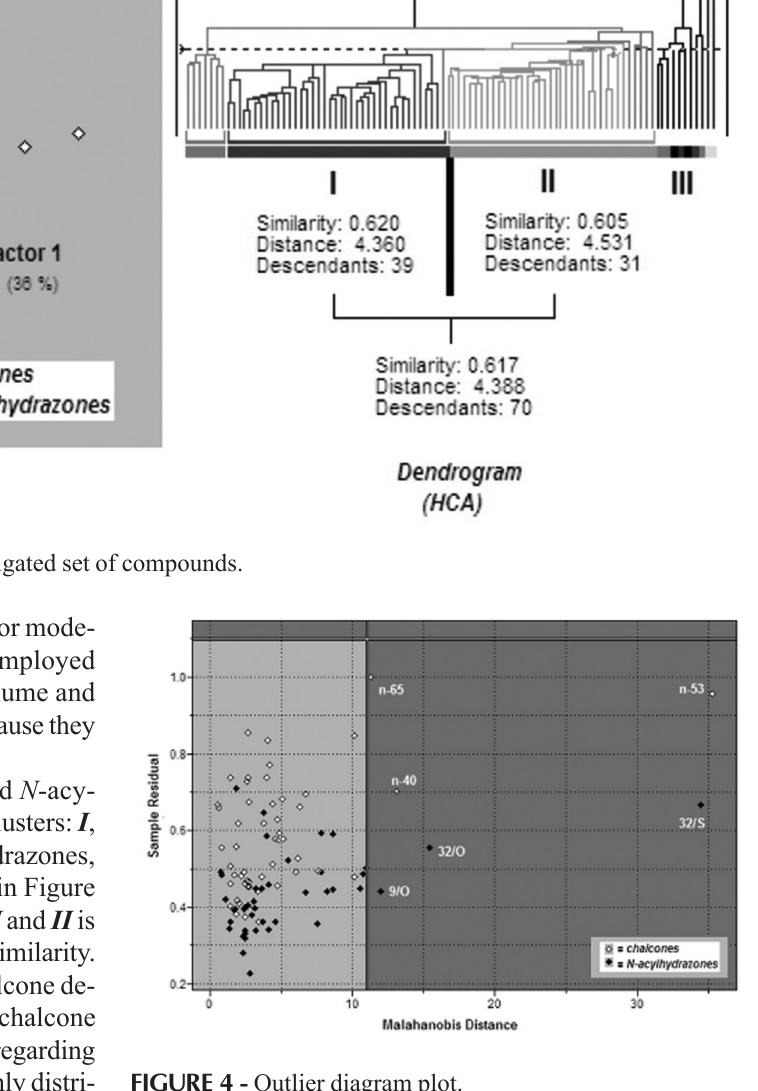
FIGURE 4 - Outlier diagram